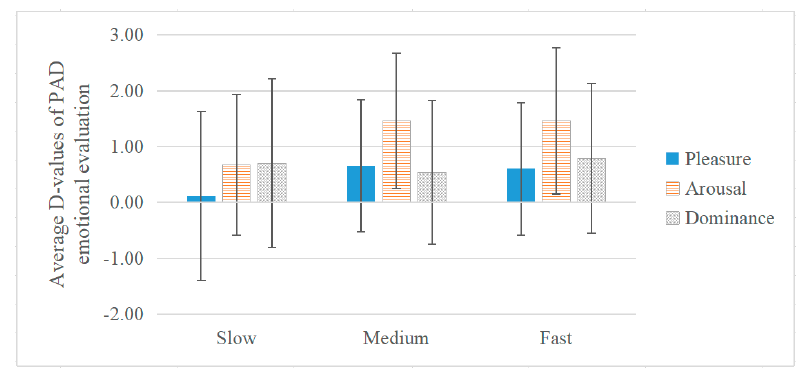
Figure 8. The E ff ect of Tempo on PAD Emotional Evaluation during Communication. Figure 8. The Effect of Tempo on PAD Emotional Evaluation during Communication.